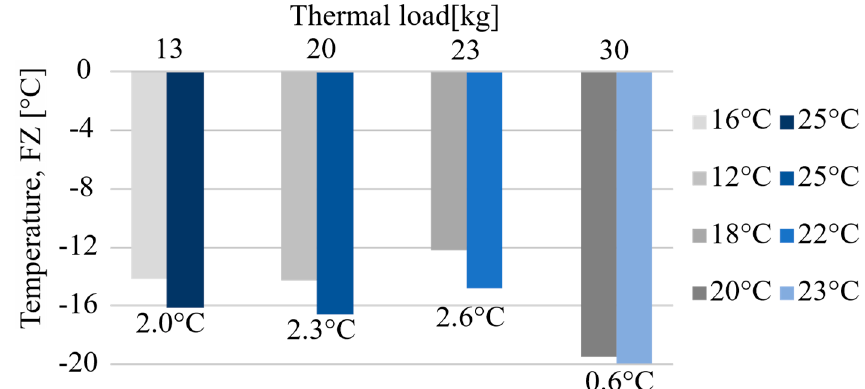
Figure 8. Temperature in the freezer compartment maintaining a constant thermal load at two temperature conditions.